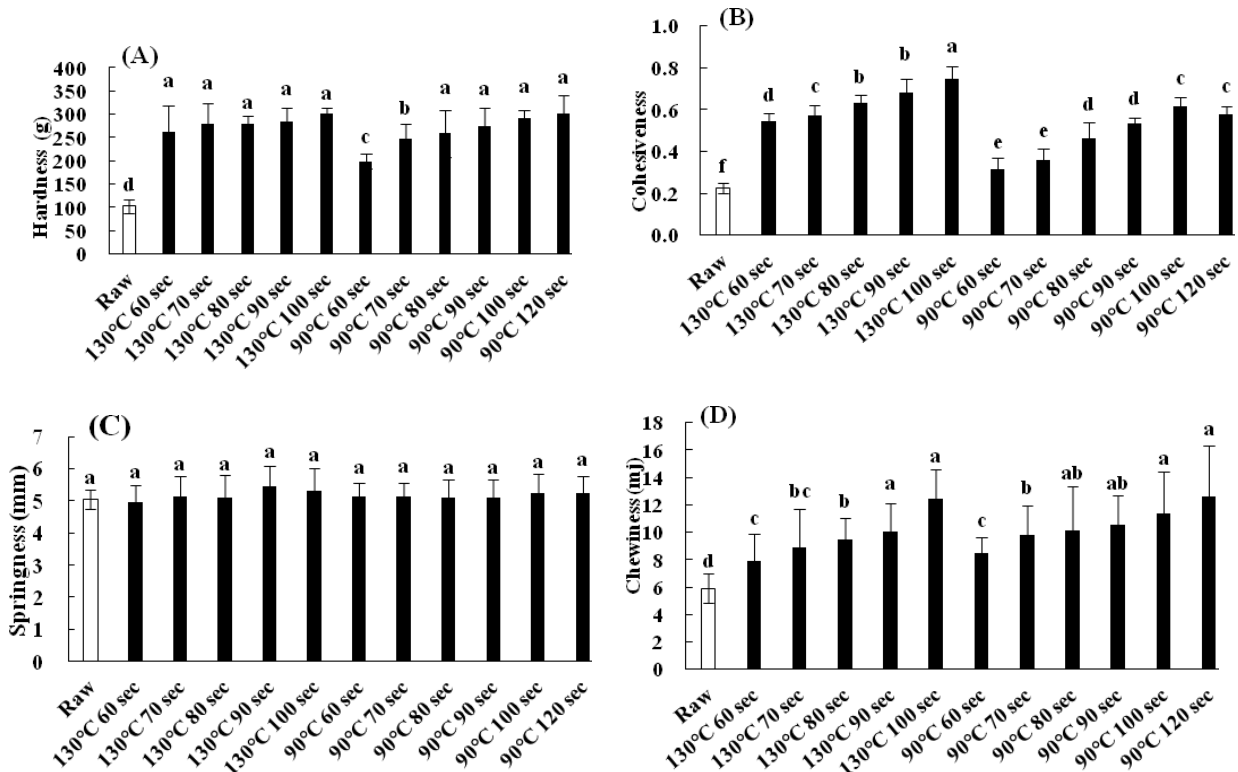
Figure 3. Changes in texture properties of hardness ( A ), cohesiveness ( B ), springiness ( C ), and chewiness ( D ), in peeled white shrimp using microwave-assisted induction heating (MAIH) system set at 130 and 90 ◦ C for different heating times. Each value is the mean ± standard deviation ( n = 4); the different letters by the bars indicate significant differences ( p < 0.05).